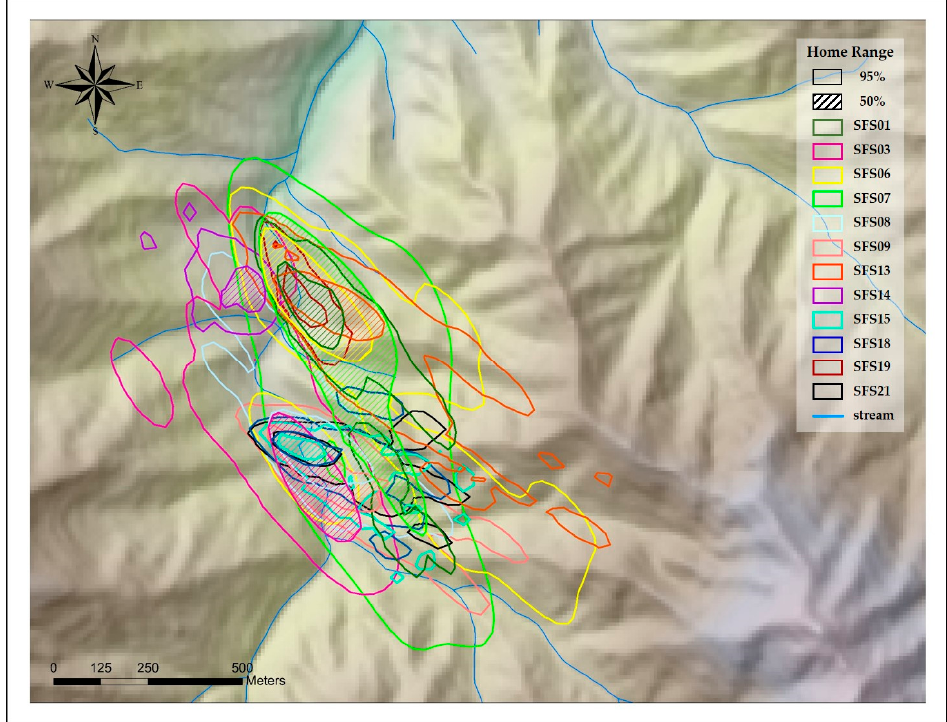
Figure 3. Home range size and core area of Siberian flying squirrels at Mt. Baekwoon, Gangwon Province, South Korea, based on the kernel density estimator (KDE).